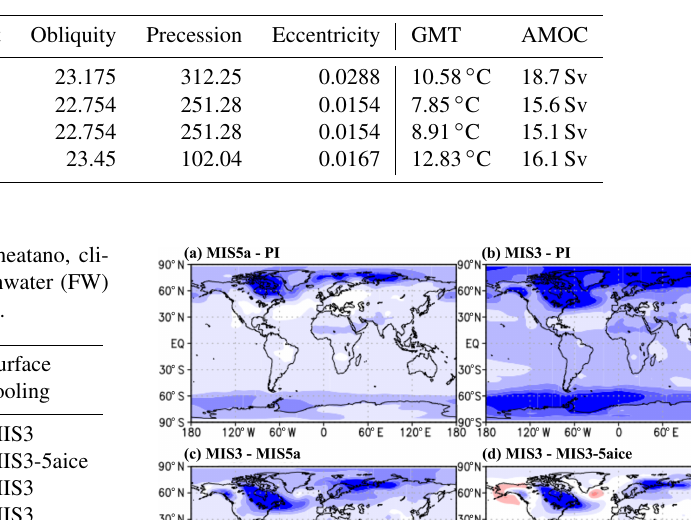
Table 1. Forcing and boundary conditions of climate simulations. Results of global mean temperature (GMT) and Atlantic Meridional Overturning Circulation (AMOC) are also shown. For reference, the results of the preindustrial climate simulation is shown.